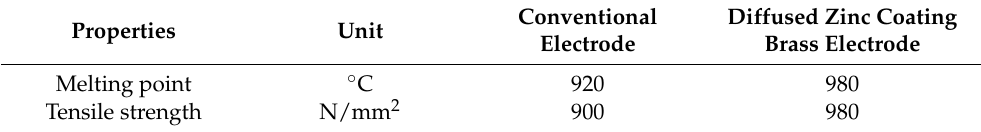
Table 1. Survey performed in the present